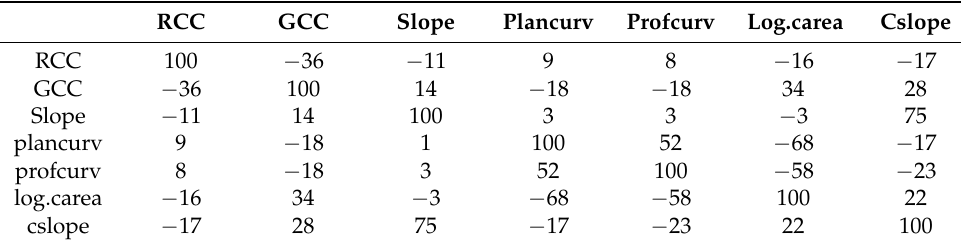
Figure 6. Variable importance plot for SVM using margin sampling in each epoch. Table 1. Correlations among the predictors (%).